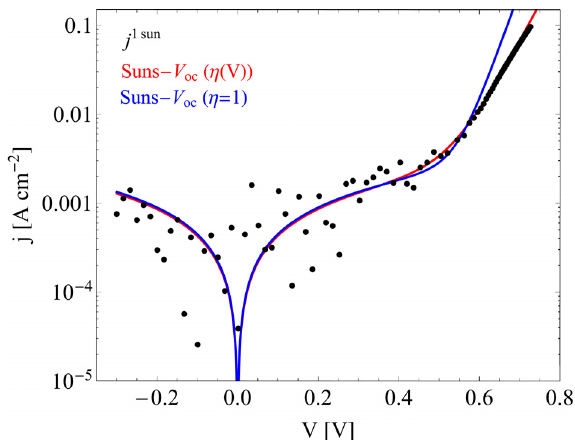
Fig. 3. The converted dark curve j 1 sun at an illumination intensity j E = 1 sun and the converted dark curve without any series resistance proposed by the outcomes of the suns- V oc analysis (voltage dependent (red) and independent (blue) photo